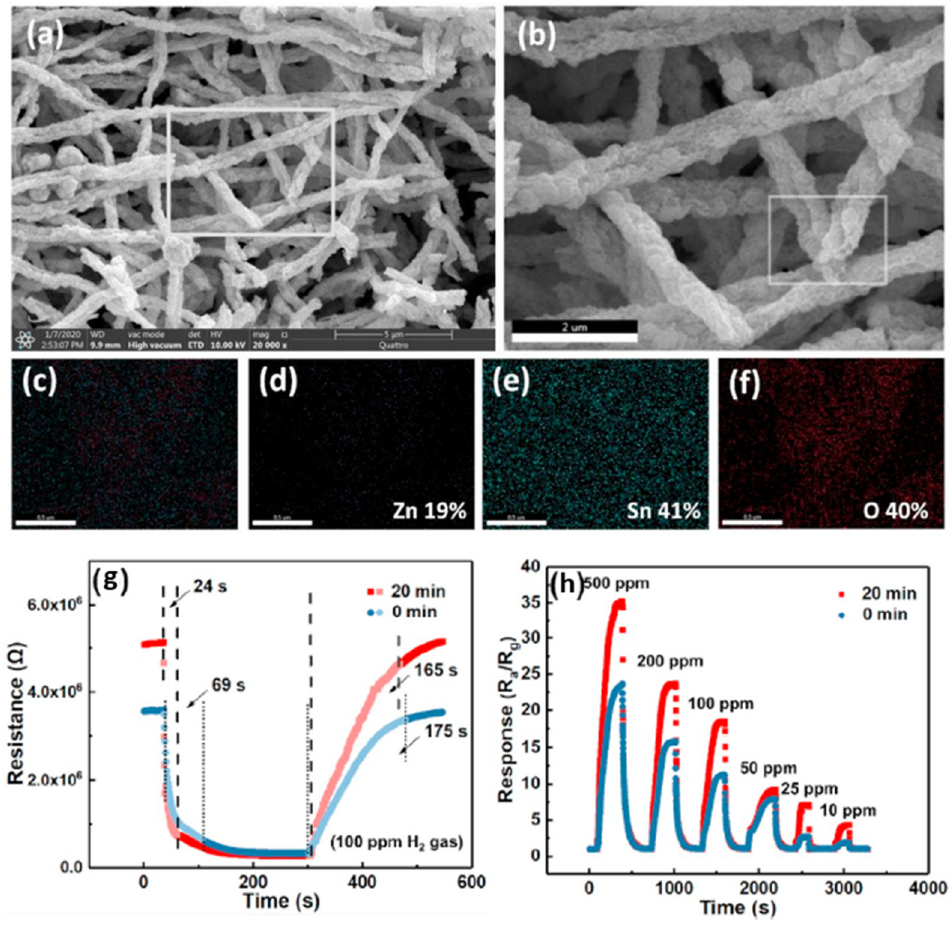
Figure 33. ( a , b ) SEM images of ZnO–SnO 2 nanofibers, ( c – f ) images of area scan by EDS including the element content of Zn, Sn, and O. ( g ) Response and recovery at optimum operating temperature 300 °C. ( h ) Response curve with 10 ppm to 500 ppm H 2 concentrations at an optimum operating temperature [123]. Copyright (2020), with permission from Elsevier.